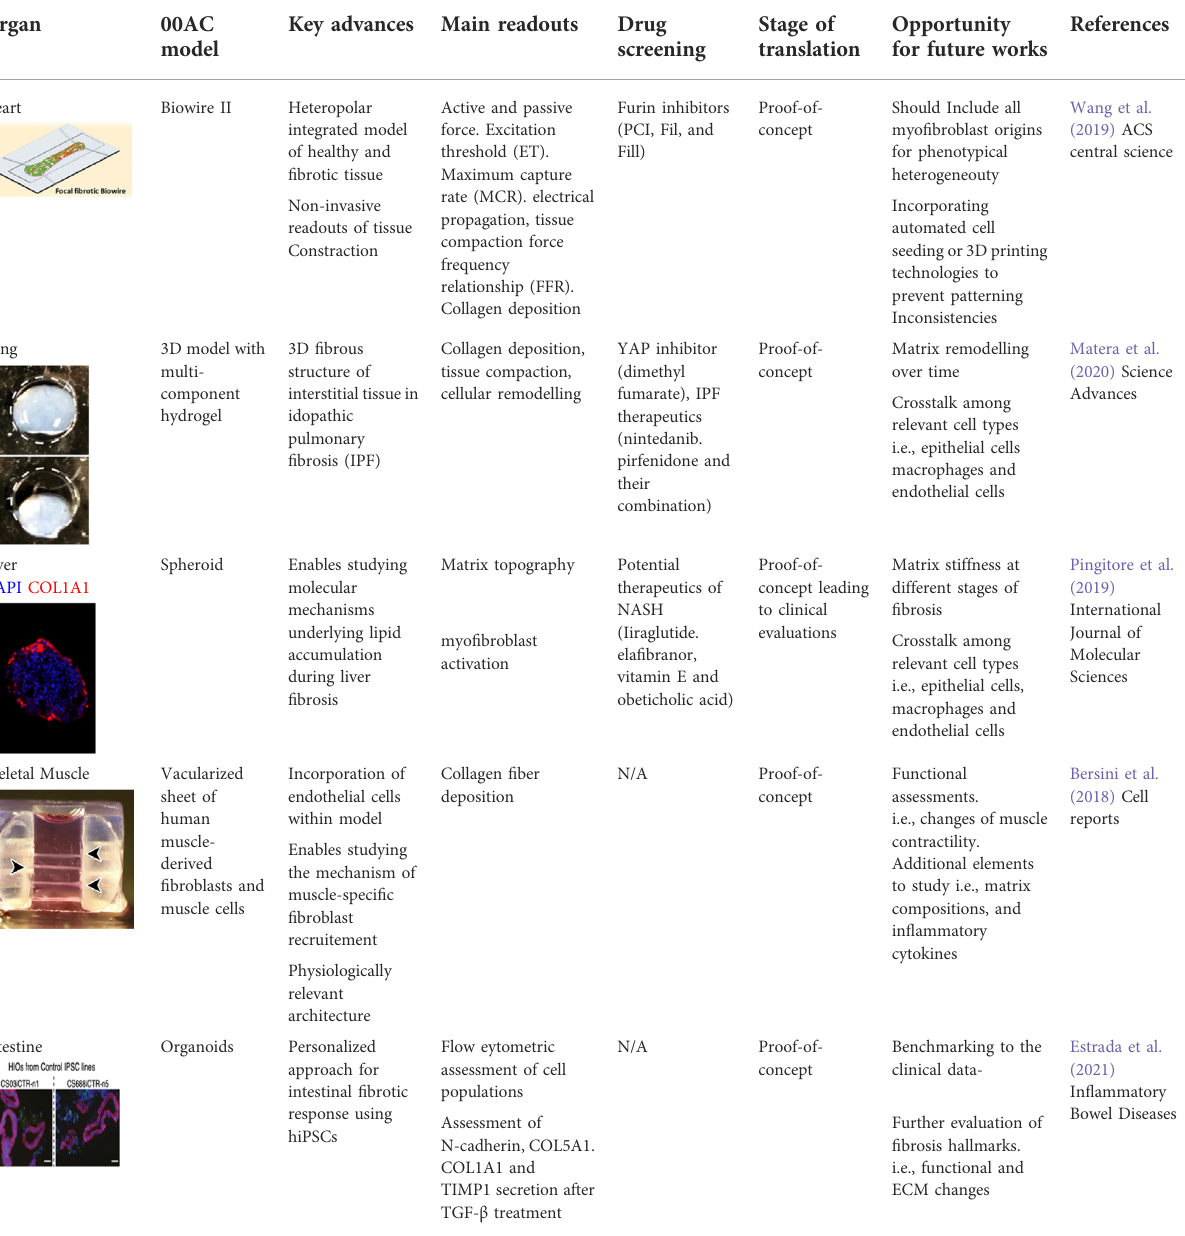
TABLE1Recent modelsofstudying fi brosis invitro .Currentmodelshavebeenabletorecapitulatevariousaspectsof fi brosis incardiac,liver,skeletal muscle, lung and intestine engineered tissues. All fi gures are reproduced under the terms of CC-BY license.